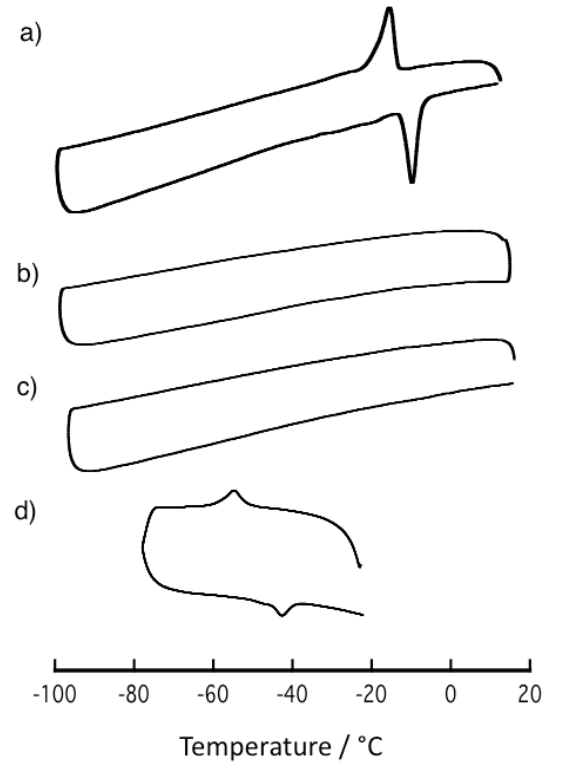
Figure 6. Differential scanning calorimeter (DSC) charts of 1 ( a ), 2a ( b ), 2b ( c ), and 5 ( d